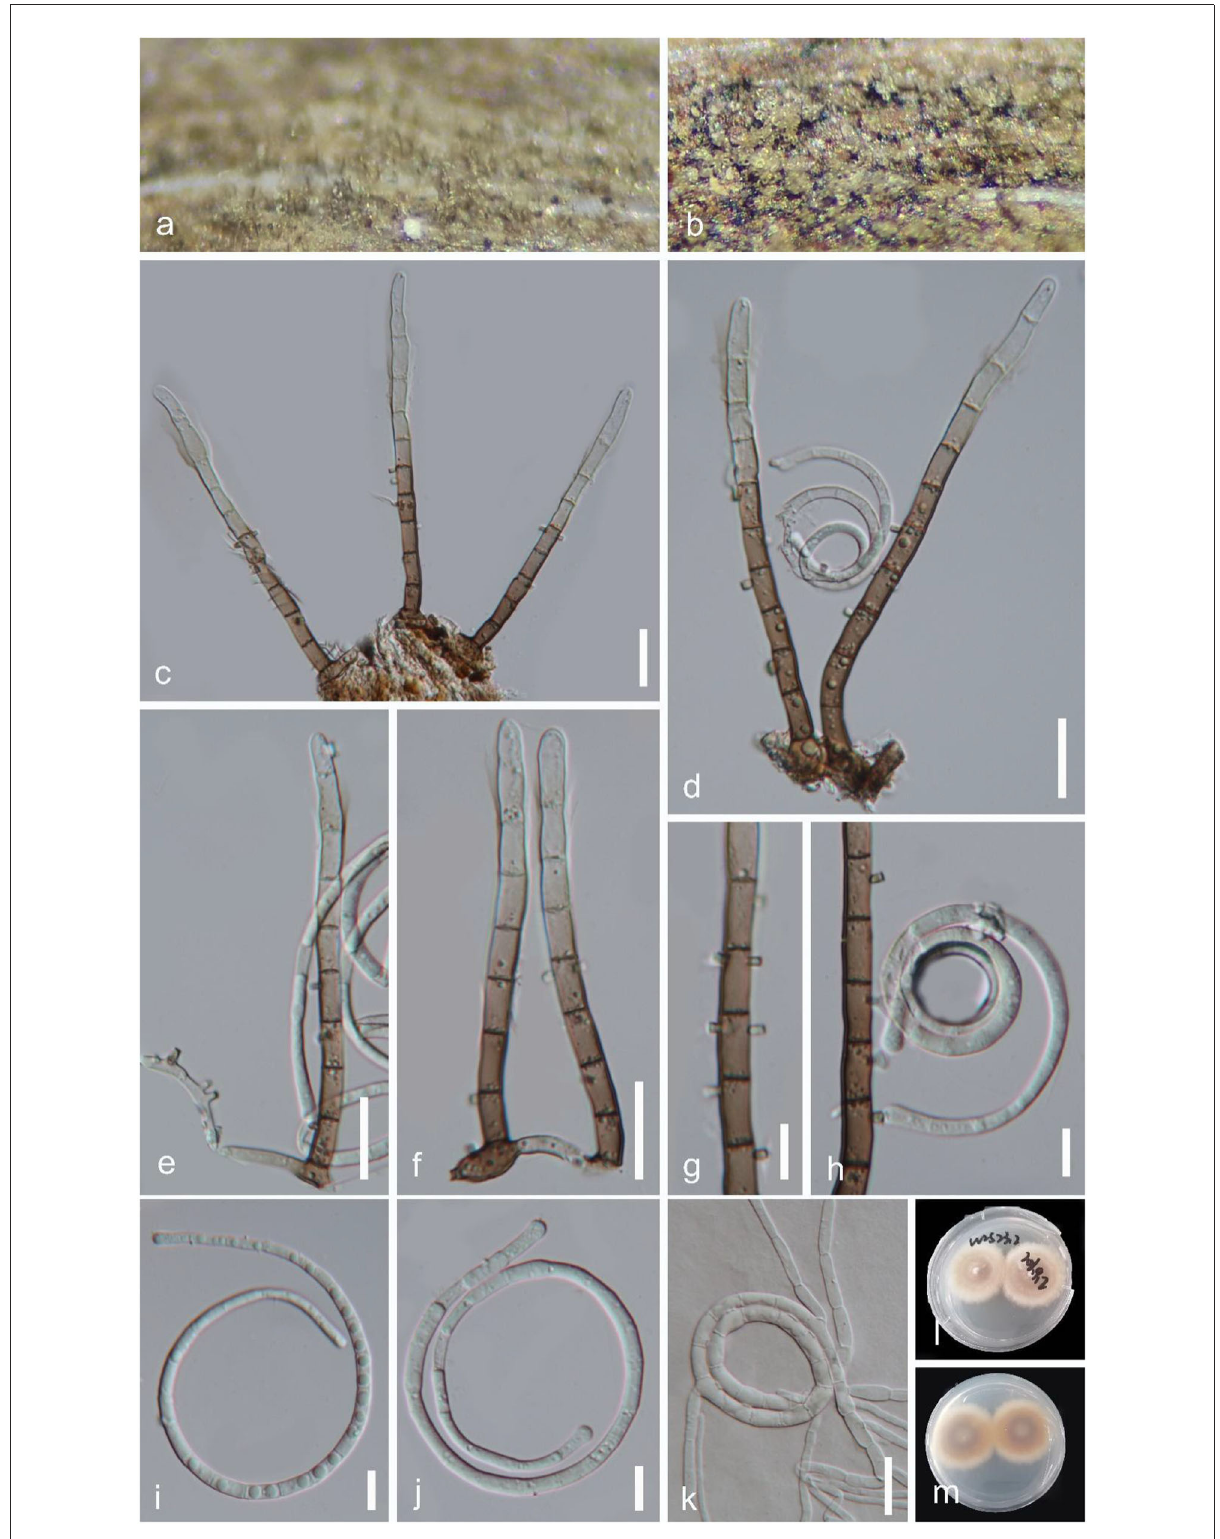
FIGURE5 Helicoma wuzhishanense (GZAAS 22-2003, holotype). (a,b) Colony on decaying wood. (c–f) Conidiophores. (g,h) Conidiogenous cells with attached conidium. (i,j) Conidia. (k) Germinating conidium. (l,m) Colonies on PDA observed from above and below. Scale bars: (c–f,k) = 20 µ m, (g–j) = 10 µ